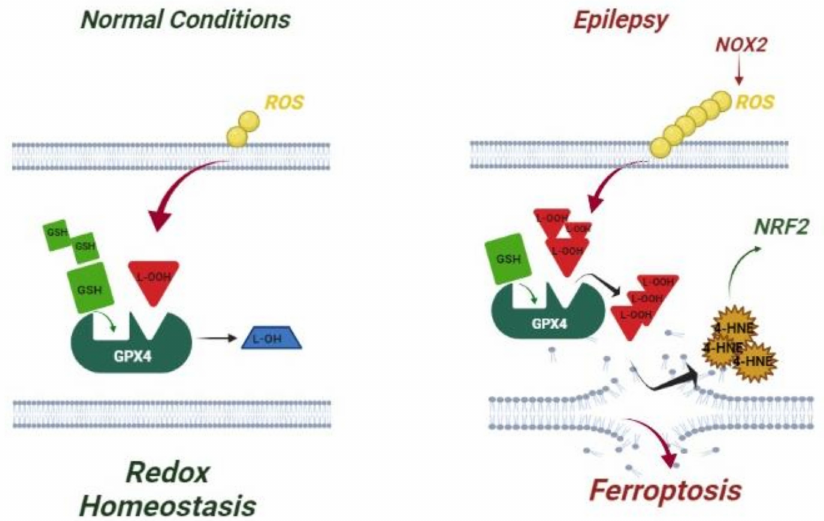
Figure 5. Representative model summarizing the main actors responsible for ferroptosis in epilepsy. In normal conditions, GPX4 detoxifies lipid hydroperoxides (L-OOH) by converting them to lipid alcohols (L-OH) and using GSH as a reaction cofactor. A balanced level of GSH and GPX4 ensures the maintenance of redox homeostasis. In epilepsy, the activation of NOX2 induces ROS overload with an increase of L-OOH that cannot be efficiently neutralized to L-OH because of decreased GSH and GPX4 contents. Consequently, L-OOHs accumulate, leading to ferroptosis and generation of L-OOHs by-products (4-HNE) that activate the antioxidant response